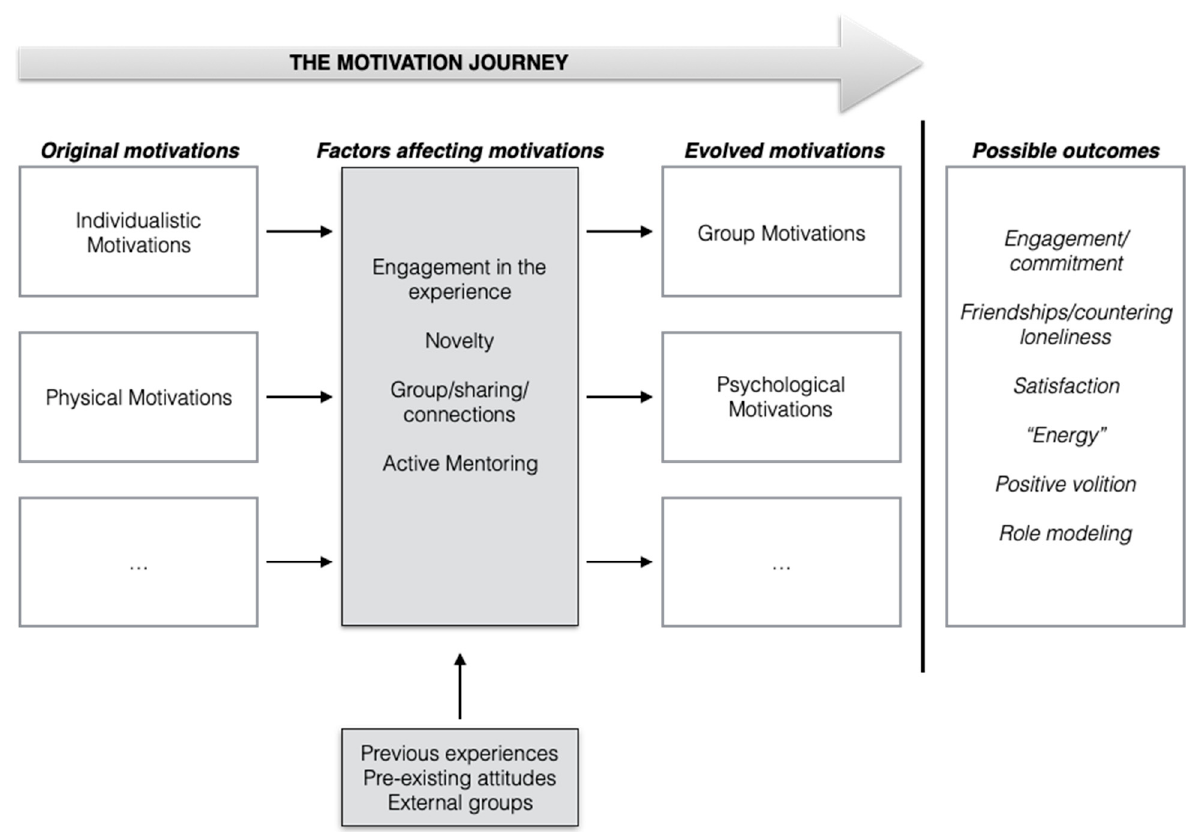
Figure 1. Grounded theory of how motivations change in a psychological intervention to promote quality of life (boxes with dots stand for other motivations that could possibly change in different interventions scenarios).